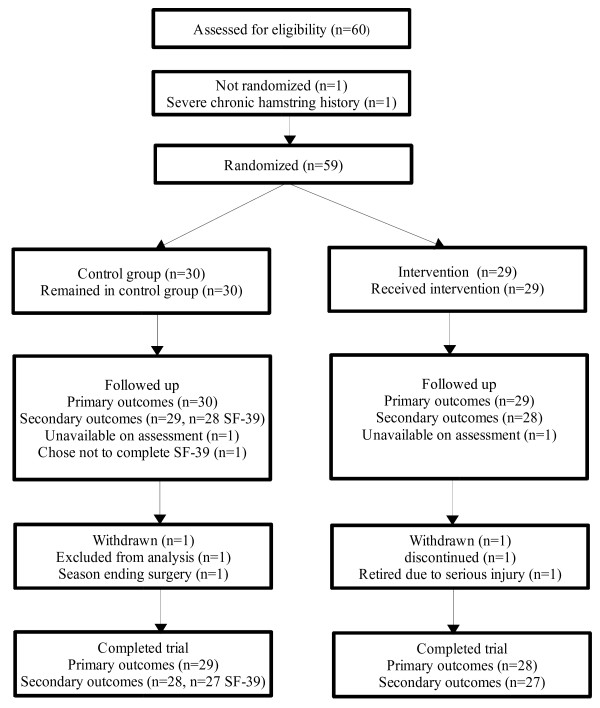
CONSORT flow chart indicating progress of subjects through the trial.